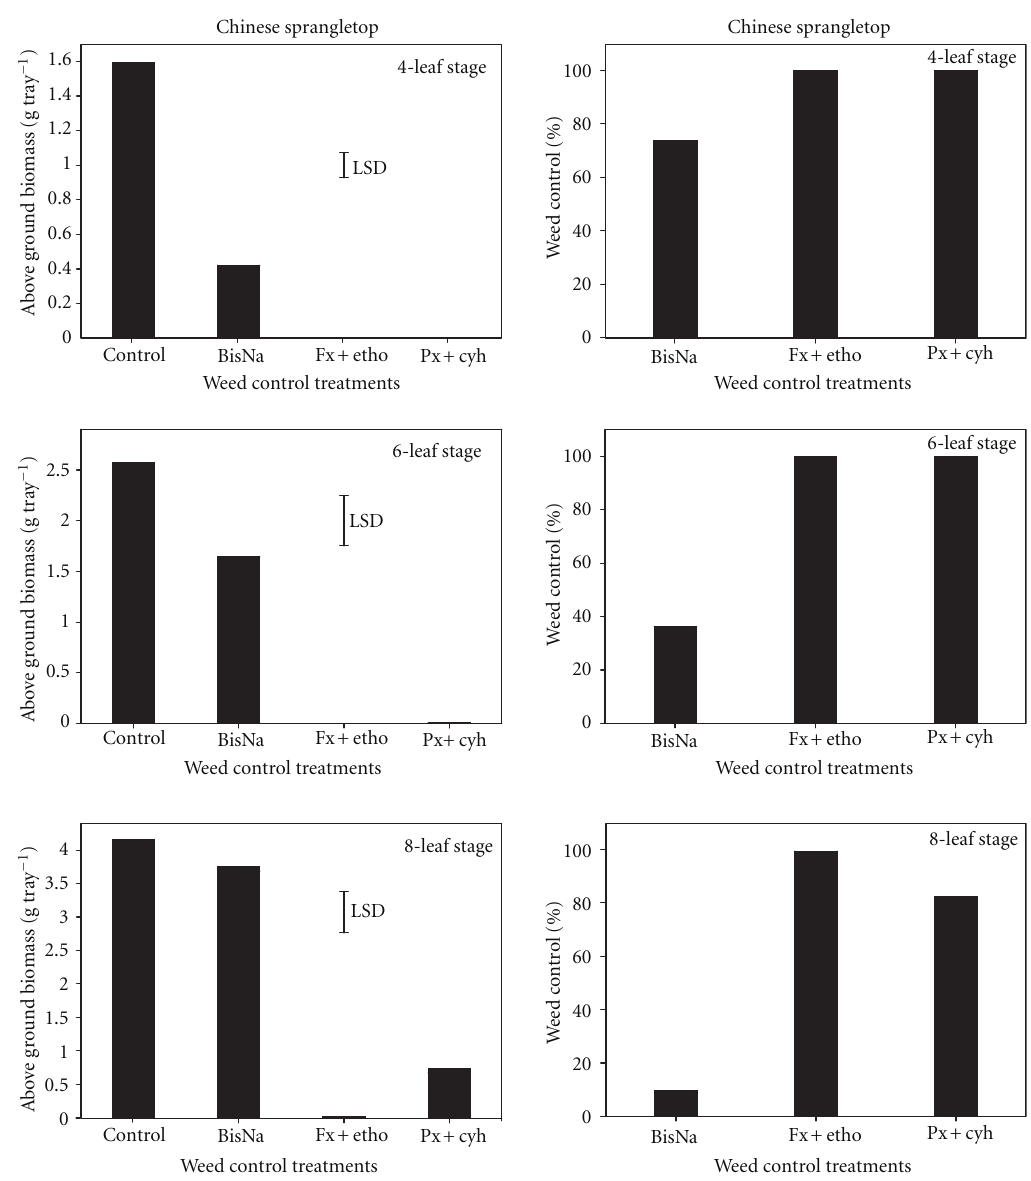
Figure 2: E ff ect of postemergence herbicides (BisNa, bispyribac-sodium; Fx + etho, fenoxaprop-p-ethyl + ethoxysulfuron; Px + cyh, penoxsulam + cyhalofop) on aboveground dry biomass (g) and control (%) of Chinese sprangletop when sprayed at its four-, six-, and eight-leaf stages. Mean comparisons were performed based on least significant di ff erence test at